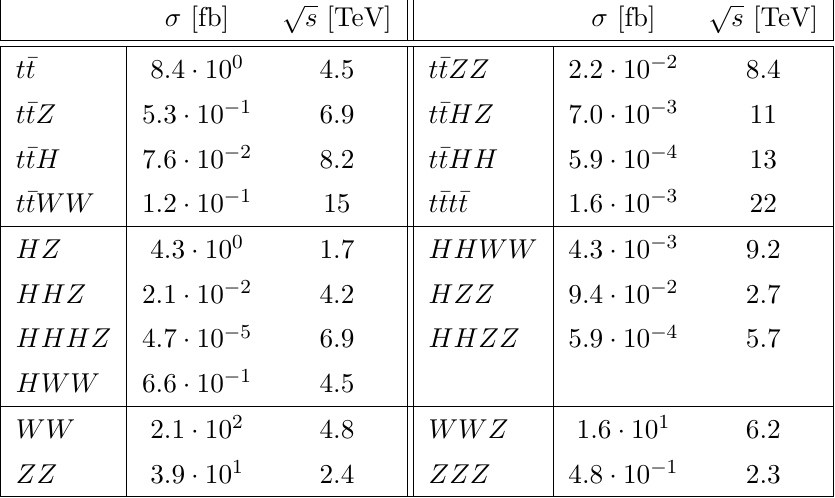
p s [TeV] and the corresponding cross section (cid:27) [fb]